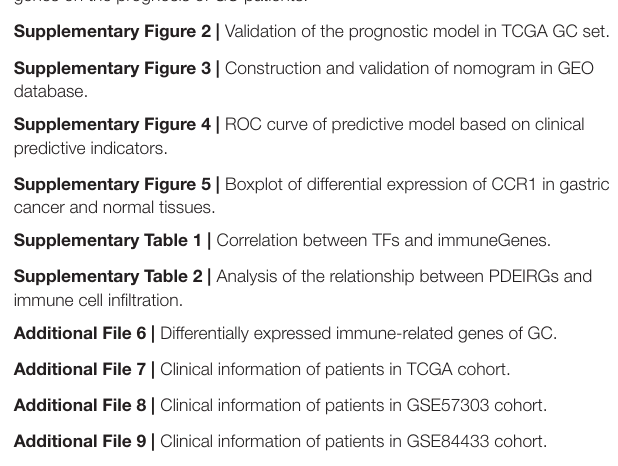
Supplementary Figure 1 | Kaplan-Meier analysis of the impact of the 2 seed genes on the prognosis of GC patients. Supplementary Figure 2 | Validation of the prognostic model in TCGA GC set. Supplementary Figure 3 | Construction and validation of nomogram in GEO database. Supplementary Figure 4 | ROC curve of predictive model based on clinical predictive indicators. Supplementary Figure 5 | Boxplot of differential expression of CCR1 in gastric cancer and normal tissues. Supplementary Table 1 | Correlation between TFs and immuneGenes. Supplementary Table 2 | Analysis of the relationship between PDEIRGs and immune cell